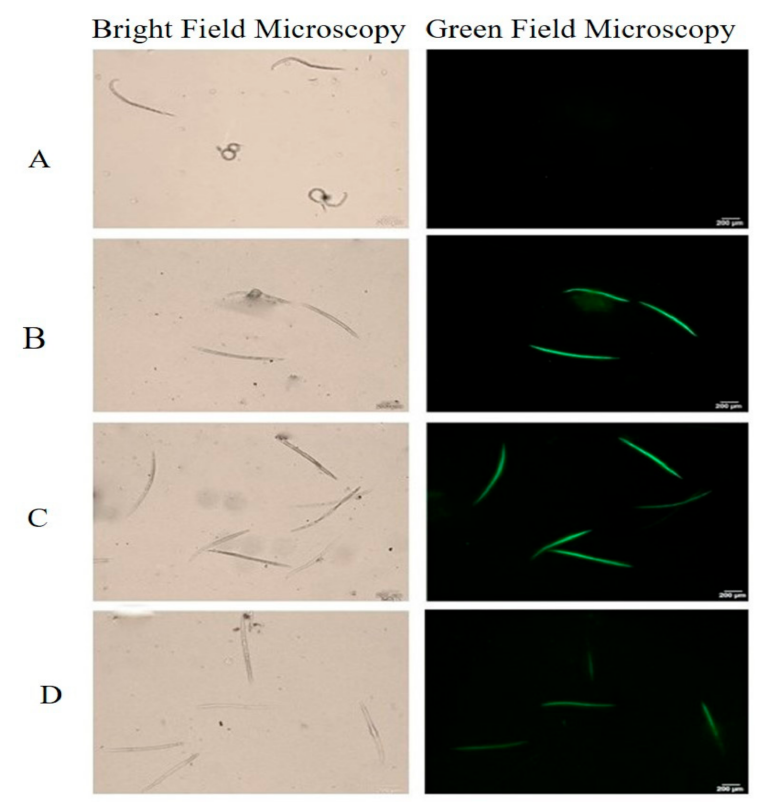
Figure 5. ROS induction by pure volatiles. ( B ) Methyl isovalerate (MIV), ( C ) dimethyl disulfide (DMDS), and ( D ) 2-undecanone (2-UD) in nematodes compared with ( A ) as control unexposed to volatiles having no ROS production. The higher level of green fluorescence indicates the high level of ROS induction in nematodes exposed to the selected volatiles. Scale bar = 200 µ